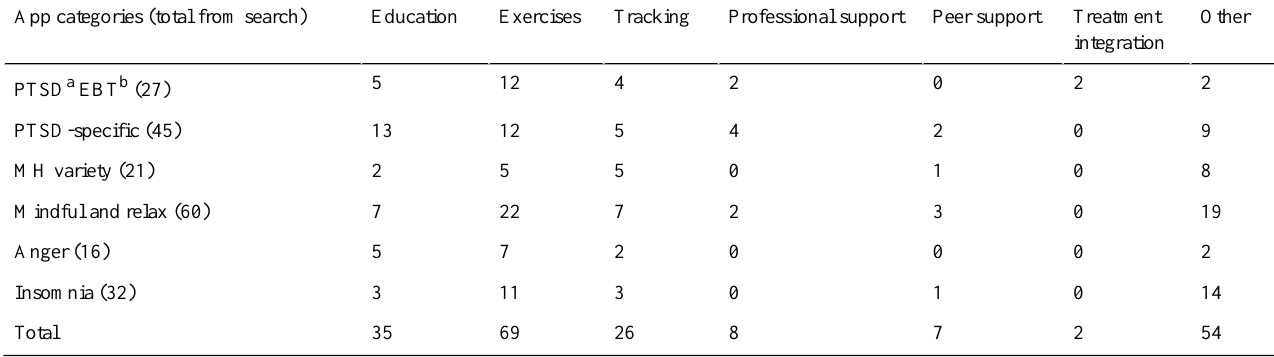
Table 2. The app tallies for different utility categories (utilities are not mutually